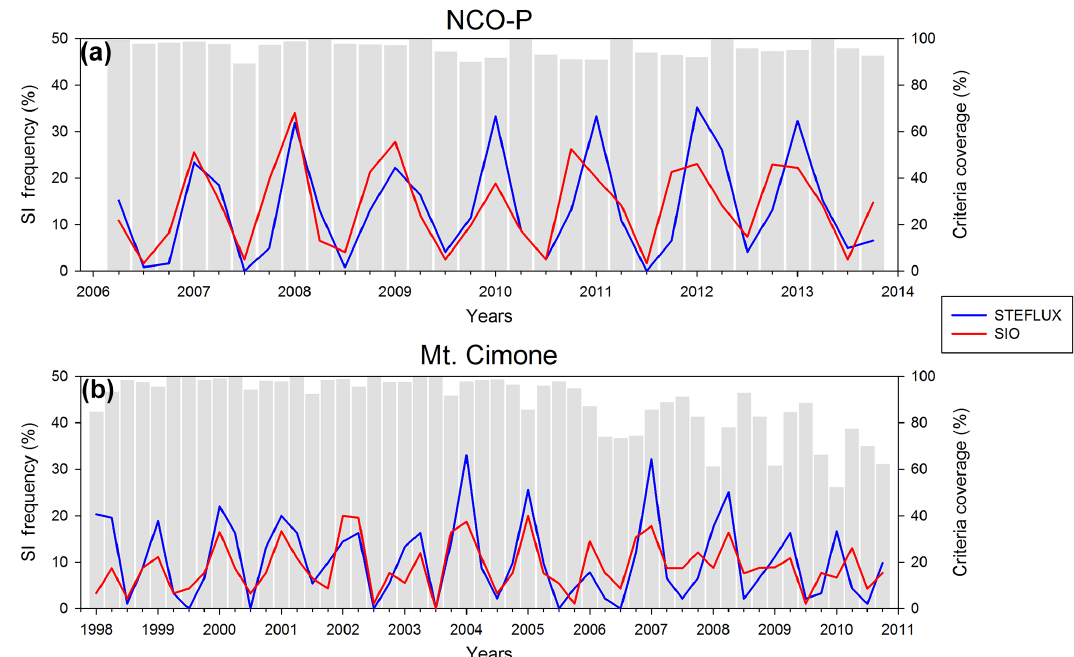
Figure 2. Seasonal graph of SI frequency at NCO-P (a) and Mt. Cimone (b) . Blue lines indicate the STEFLUX outputs (for the configuration parameters see the Supplement), while the red ones represent the results from the application of the criteria presented in Sect. 2 (SIO). Also shown in the plot is the percentage of criteria coverage (grey bars) for each season.